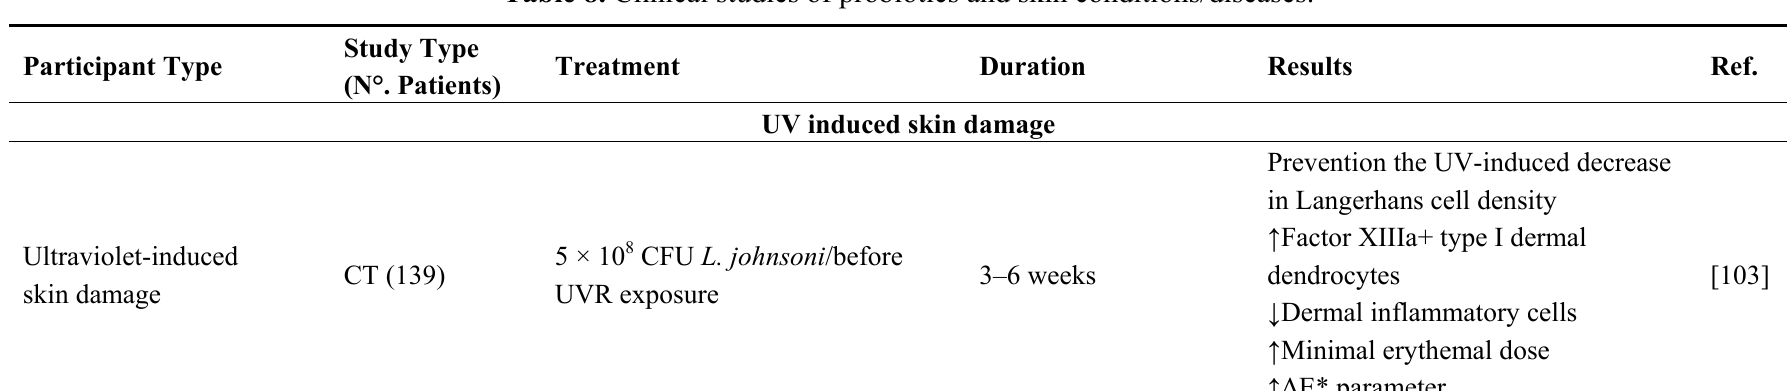
Table 8. Clinical studies of probiotics and skin